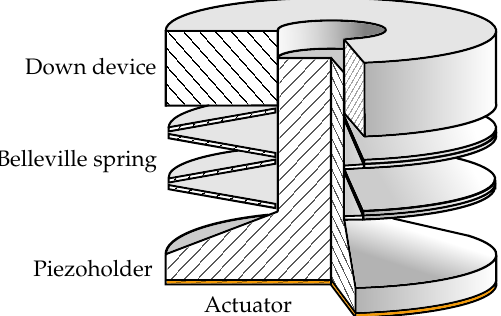
Figure 2. Principle of the developed ultrasonic transducer used throughout this study, diameter